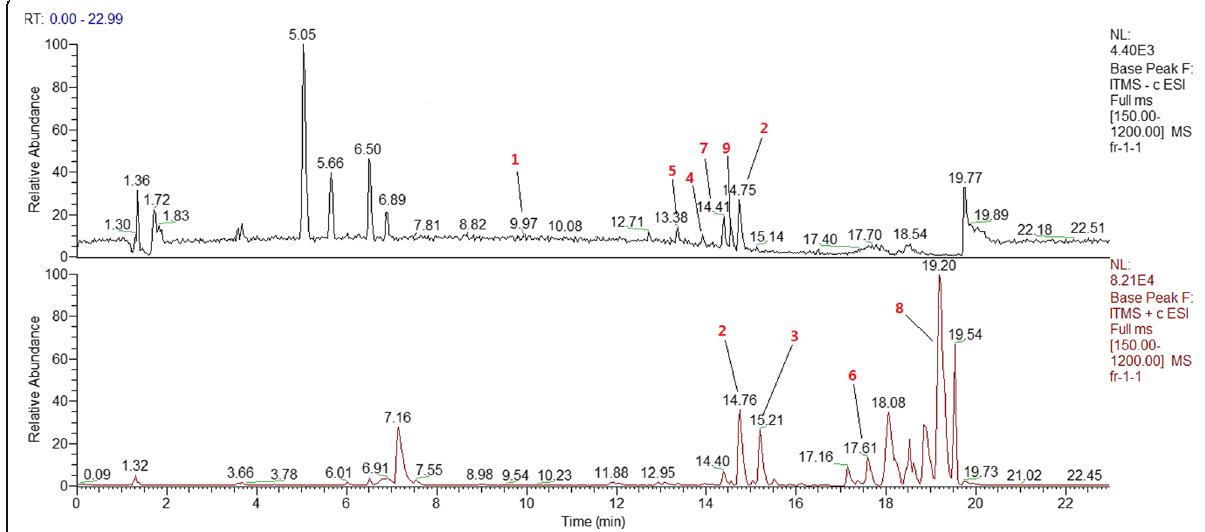
Fig. 2 HPLC-MS chromatogram of E. rutaecarpa extract